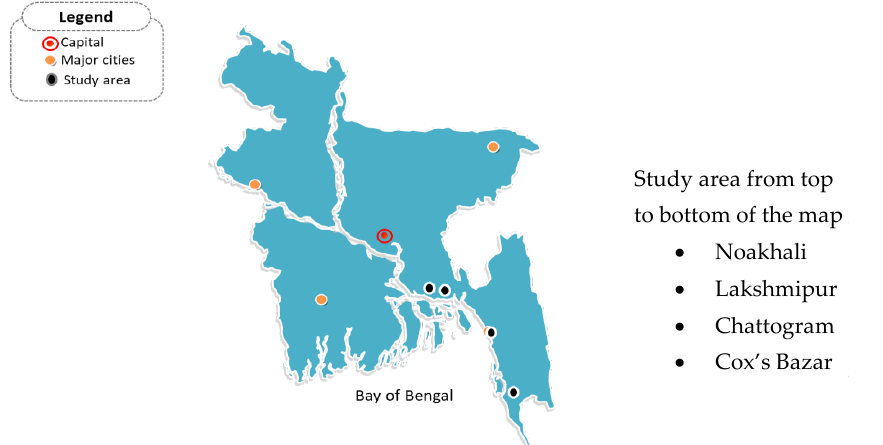
Figure 2. Rice plant sample collection sites (black bullets) in Bangladesh. To isolate and screen the effective salinity-tolerant bacteria, isolated bacteria from the rice plants were cultured in NBA medium containing the varying concentrations: 2%, 4%,